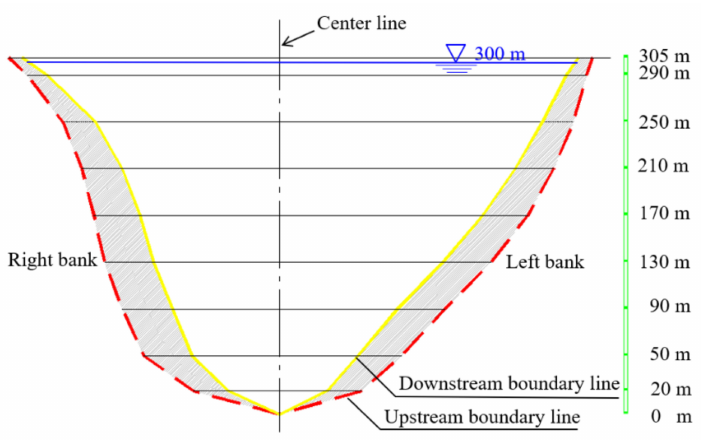
Figure 1. The geometry of the arch